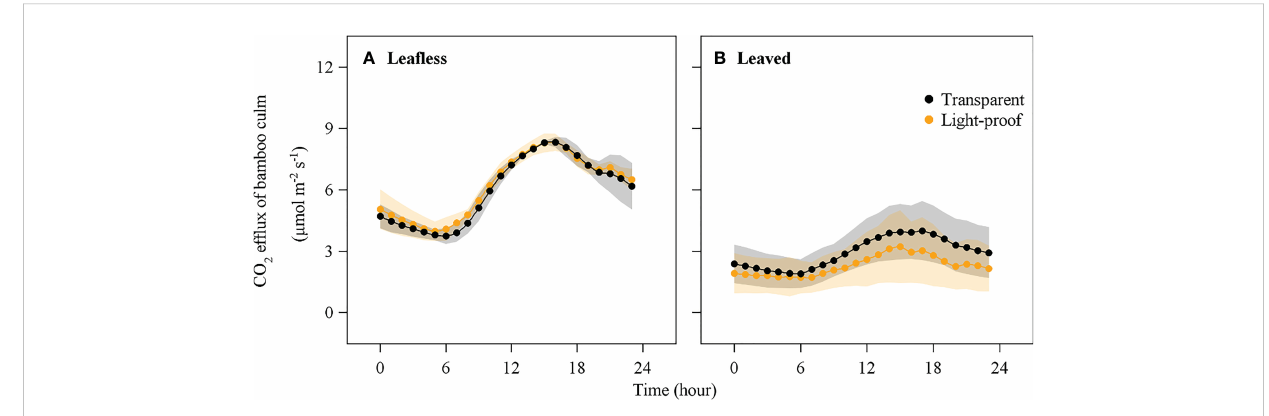
FIGURE 3 CO 2 ef fl ux of bamboo culm ( E s ) in the transparent and light-proof chambers in lea fl ess (A) and leaved (B) stages (mean ± std, n =